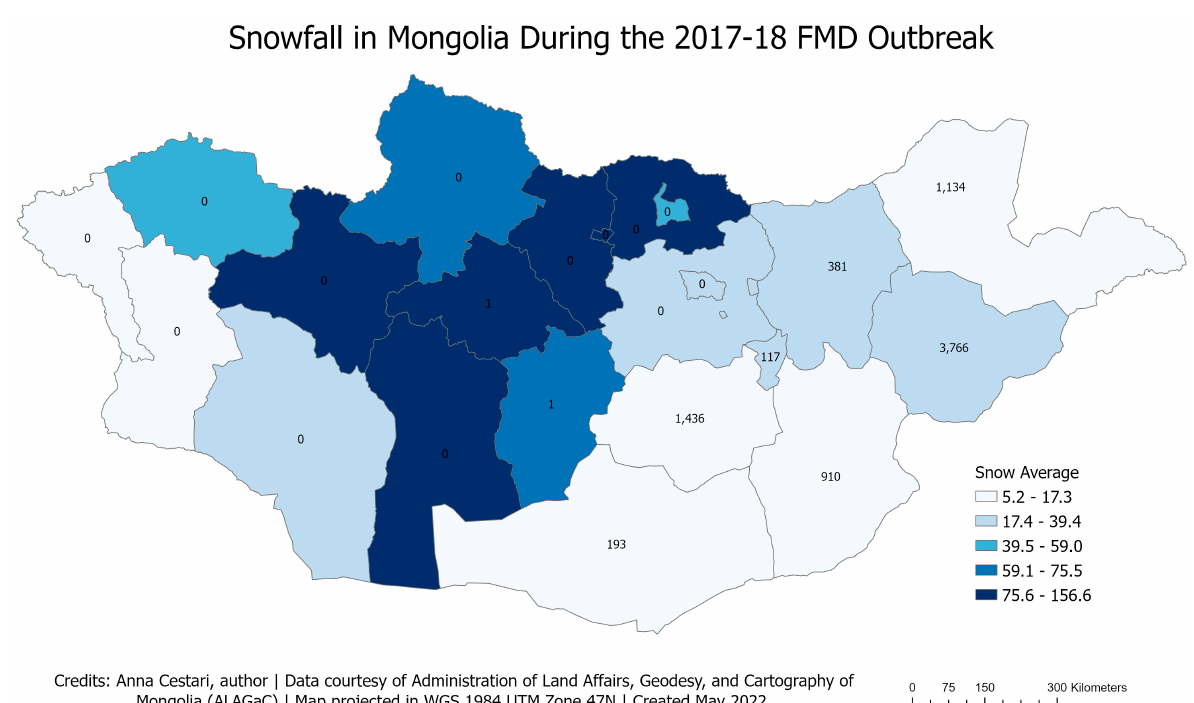
Figure 8. This map shows the provinces in Mongolia with color shading based on the amount of snowfall. The darker colors represent more snowfall. Each province is labeled with its number of foot and mouth disease cases for the 2010 FMD outbreak.